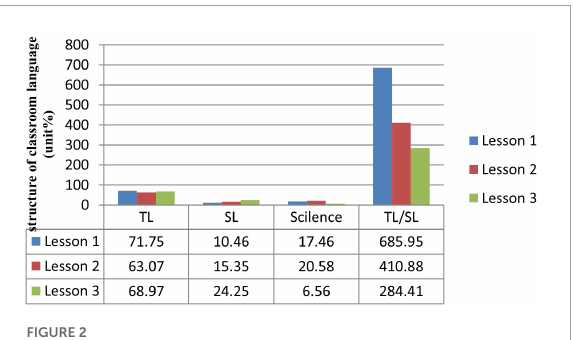
FIGURE2 The ratio of three categories of classroom language at the three lessons.